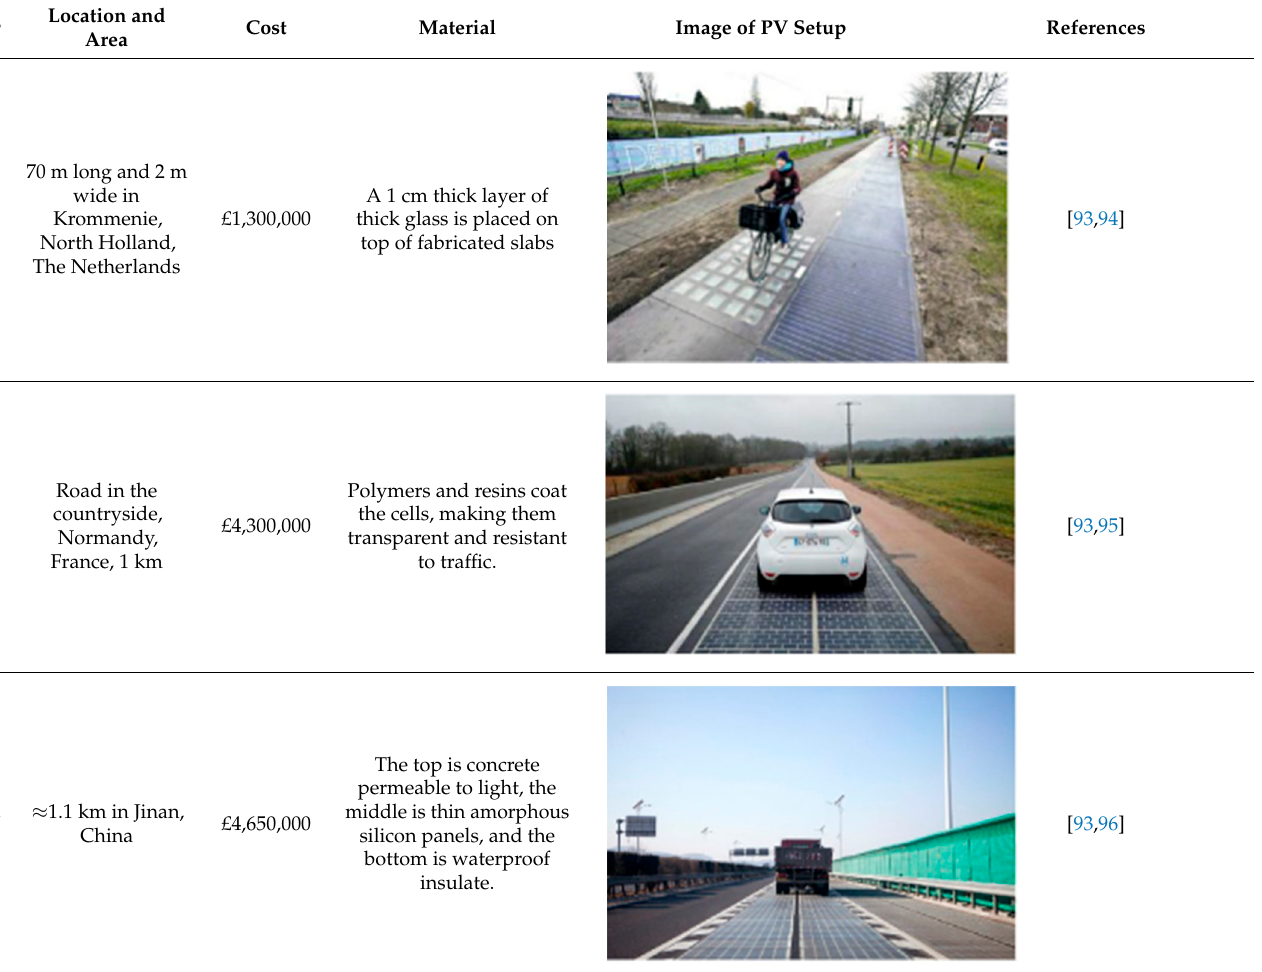
The top is concrete permeable to light, the middle is thin amorphous silicon panels, and the bottom is waterproof